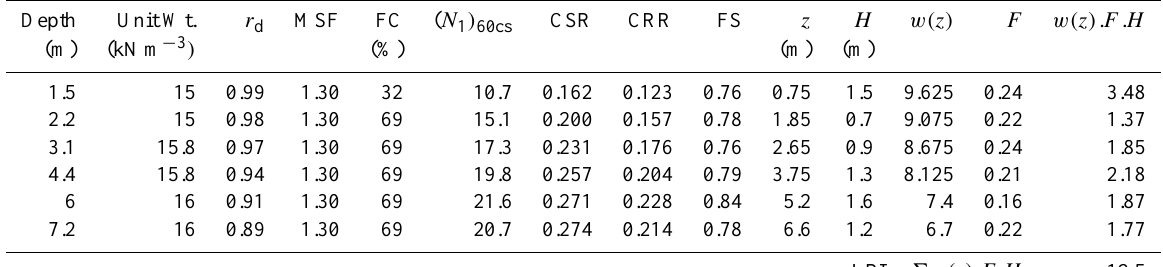
Table 4. Computation of LPI for PGA 0.3 g corresponding to M w = 6.5. Depth Unit